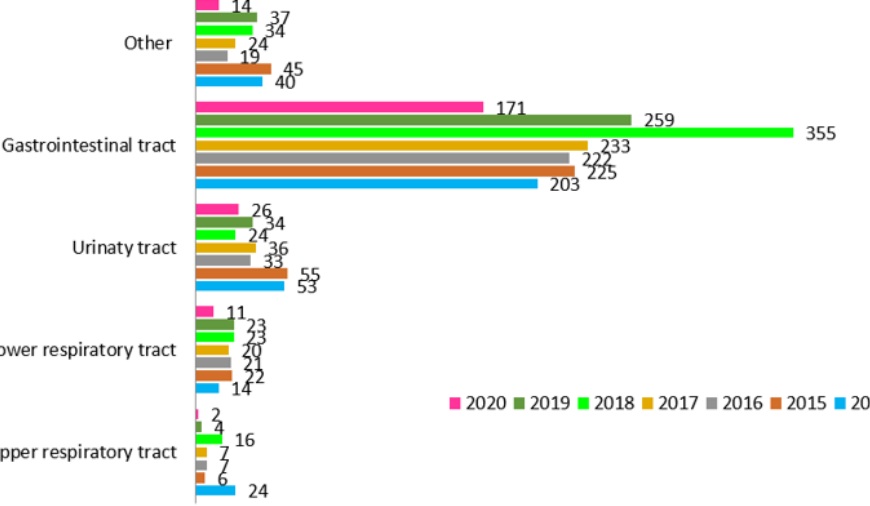
Figure 4. Number of mycological samples divided into 5 source groups.